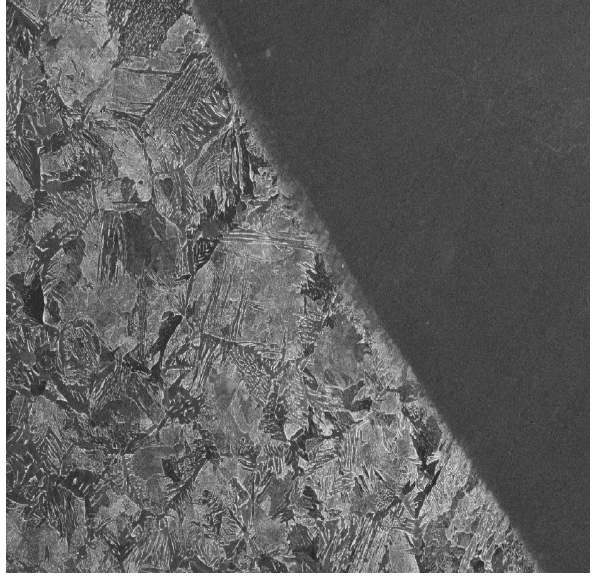
Figure 9: Structure of HAZ and weld of S235JR steel Melting and solidification process changes the crystal- lographic structure affecting on strength characteristics.